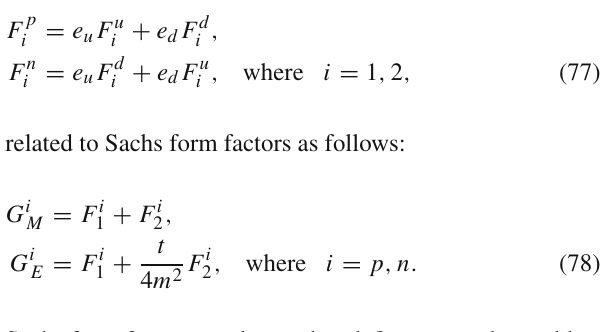
Fig. 3 Comparison between PDF sets by NNPDF group [85,87] and parameterizations based on Eq. (74). The upper (lower) row is for unpo- larized (polarized) PDFs. For a given row, the left plot is for u val quarks, while the right one is for d sea quarks. For a given figure, the black solid